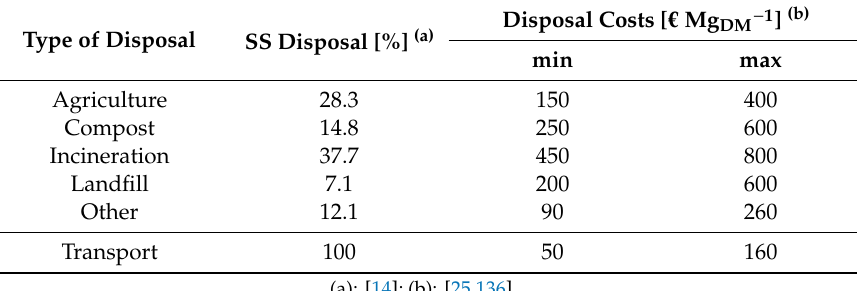
Table 7. Sewage sludge (SS) disposal options and costs in